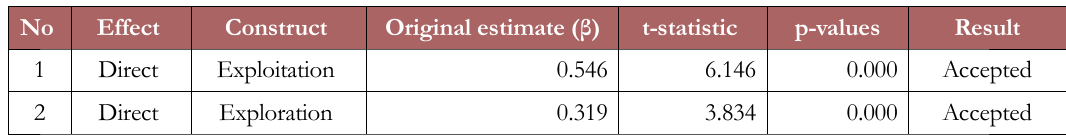
Table 8. Hypothesis test result for exploration and exploitation to CIC in service industry